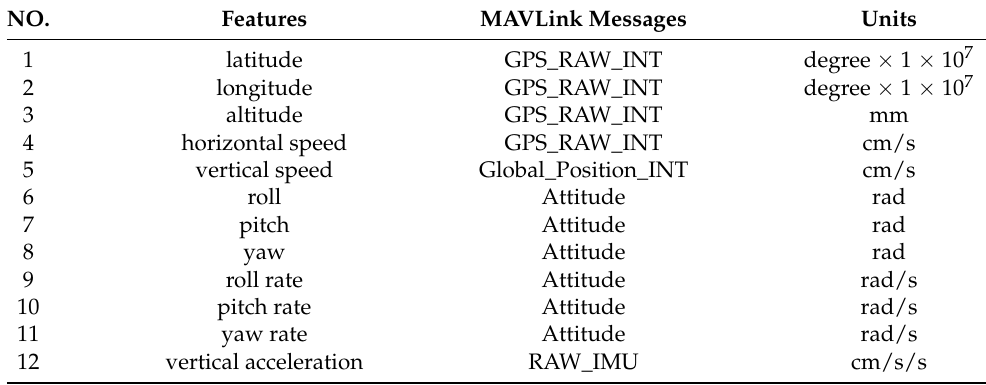
Table 2. MAVLink messages for onboard feature data